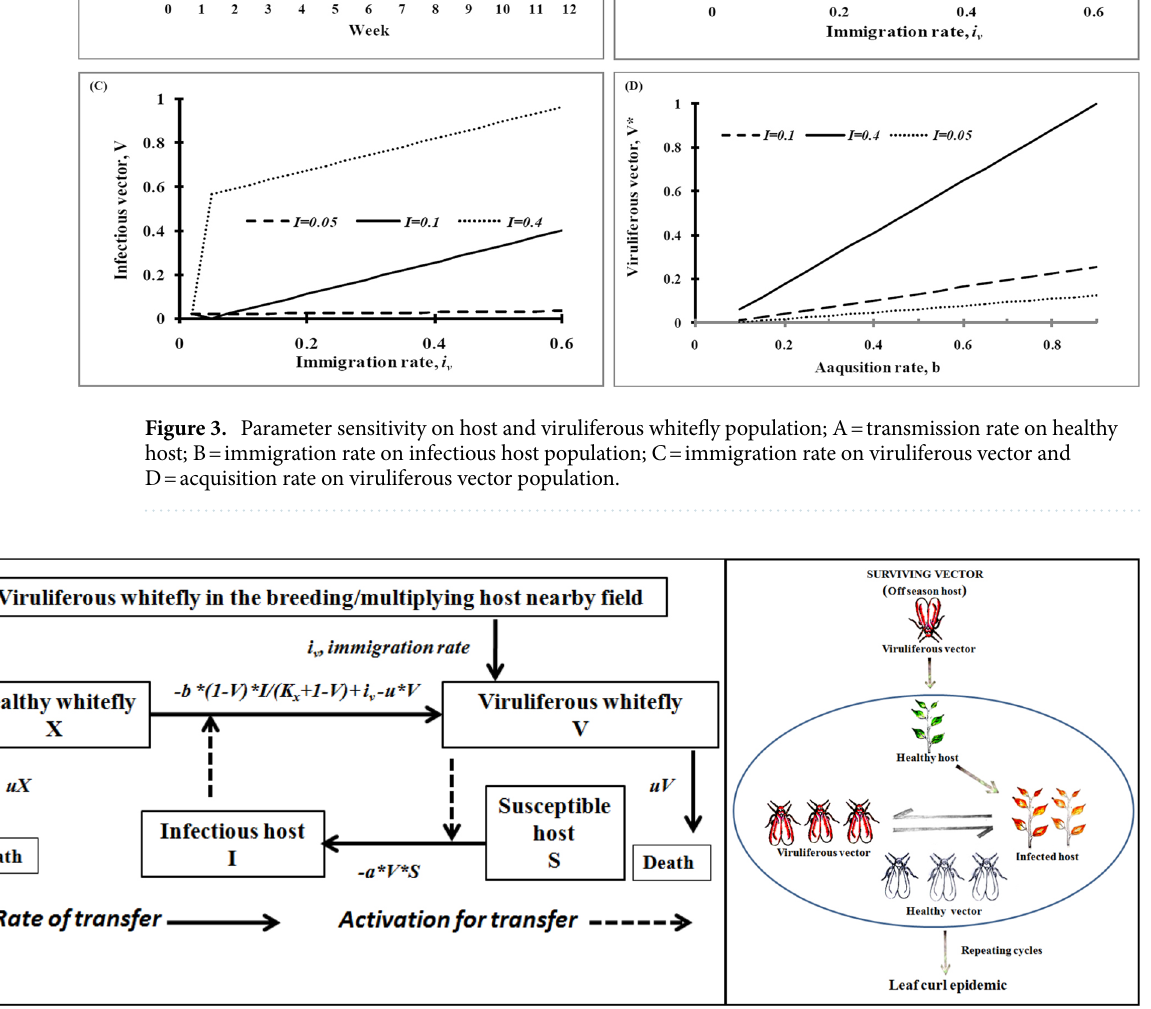
Figure 4. Schematic representation of dynamic tripartite interactions in leaf curl epidemic on a susceptible chili cultivar. Left = interaction between host and vector leading to virus transmission; Right = migrant viruliferous vector infects host that serves as source of virus for aviruliferousvectors and which in turn infect healthy